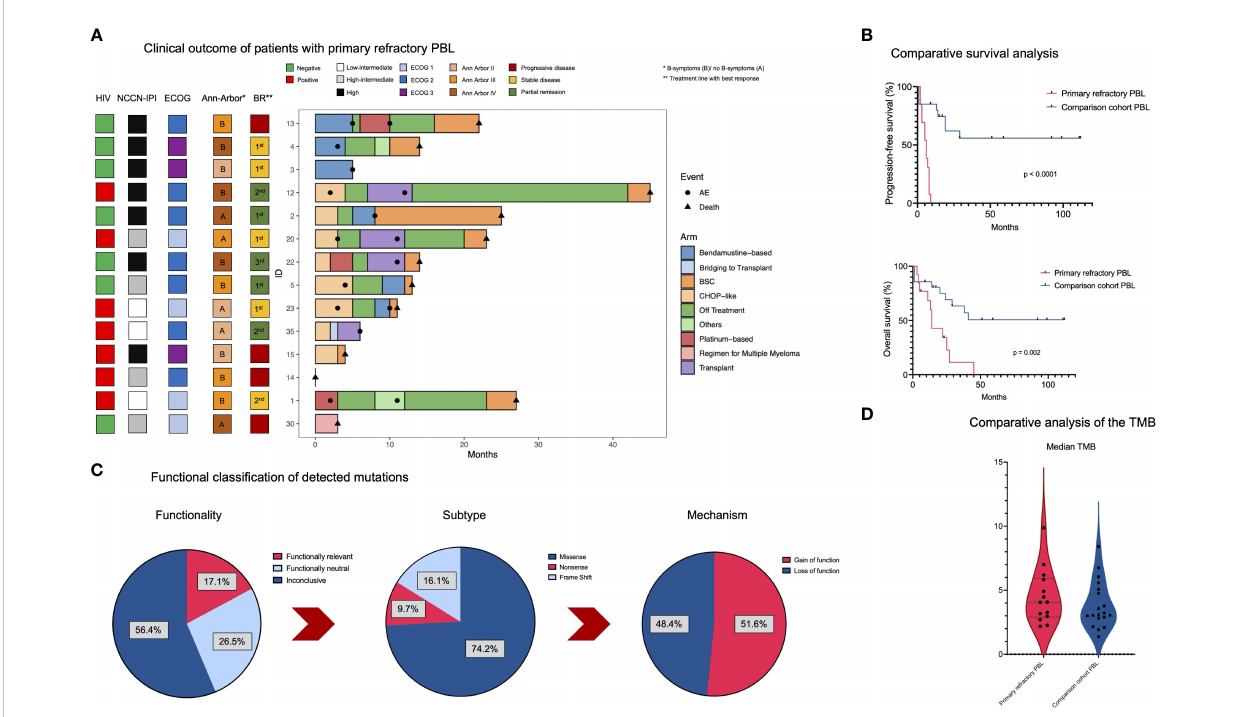
FIGURE 2 Clinical and genomic features in prPBL. (A) The swimmer plot illustrates the clinical course of the disease for each prPBL case. (B) Kaplan Meier survival analysis (PFS and OS) comparing prPBL cases and the comparison cohort which were not associated with primary refractory disease. (C) Pie charts outlining functionality, the mutational subtype and the mechanism of detected mutations. (D) Comparative median TMB calculation between prPBL and the comparison